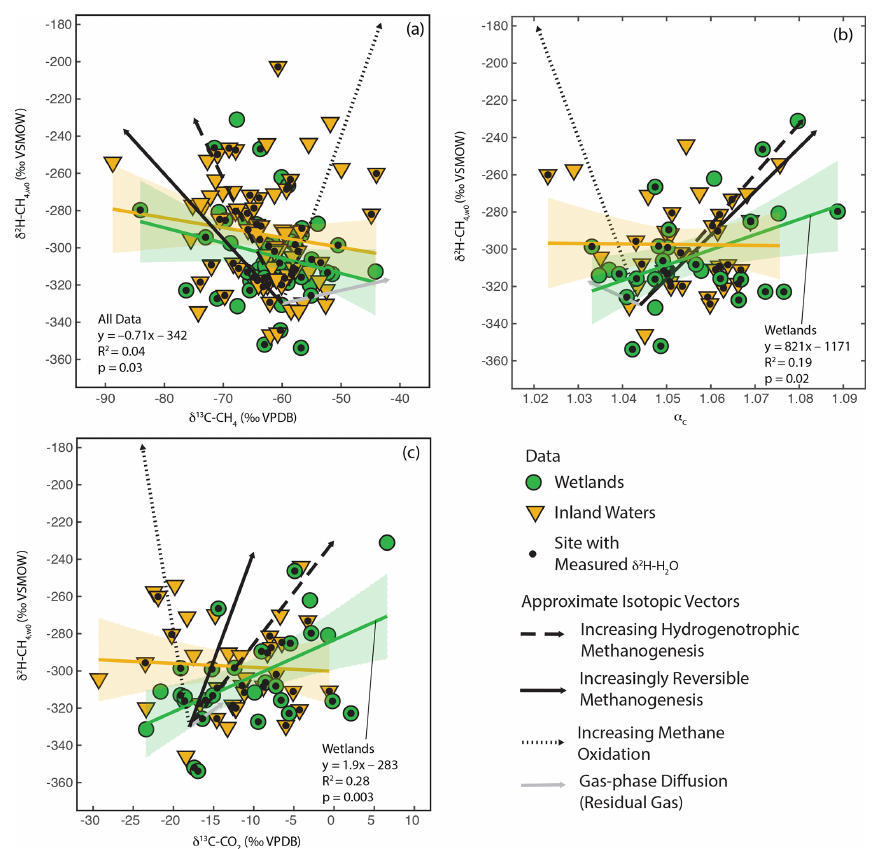
Figure 6. Scatter plots of δ 2 H–CH 4 ,w 0 vs. (a) δ 13 C-CH 4 , (b) α c , and (c) δ 13 C–CO 2 . Approximate vectors for isotopic co-variation related to four biogeochemical variables are shown. See details in Sect. 3.4 and the Supplement. Regression relationships are shown for wetland and inland water sites, with envelopes indicating 95% confidence intervals. Regression statistics are shown here for relationships with significant correlations ( p< 0 . 05). All regression statistics are detailed in Supplement Table S4 (Douglas et al.,